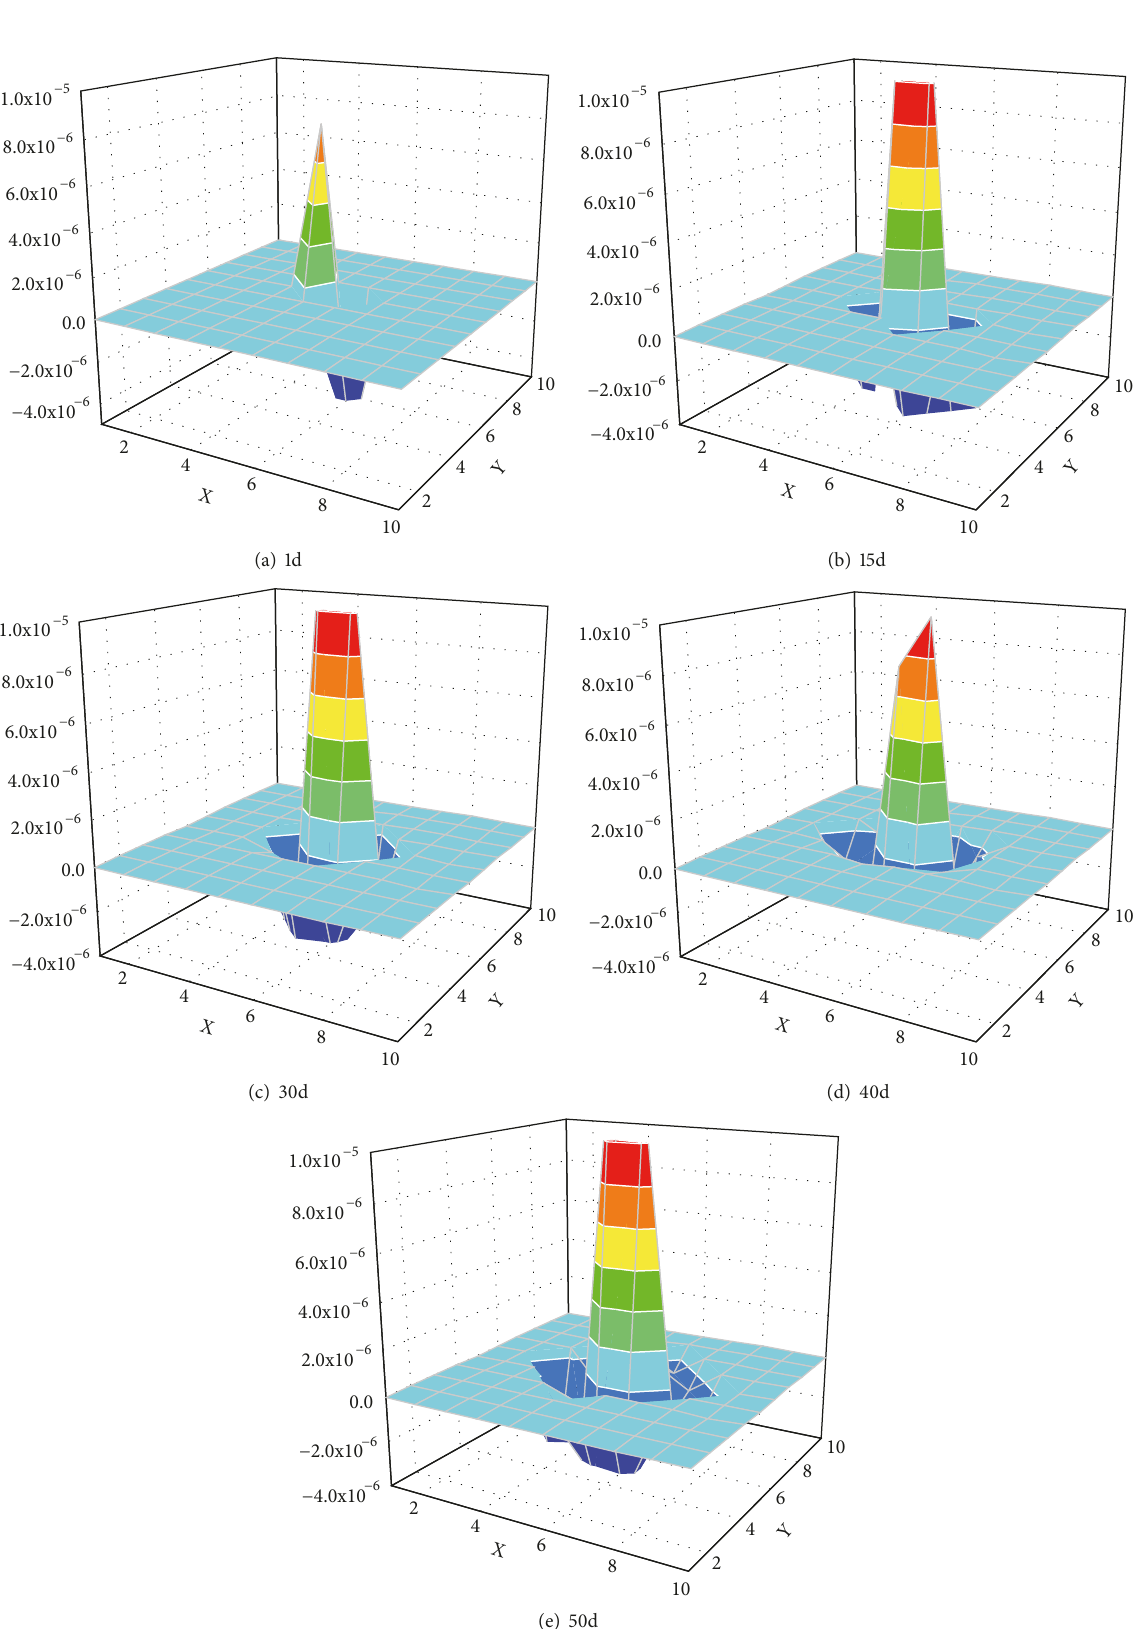
Figure 3: Current density distribution of smear damage system in 1% NaCl solution at different